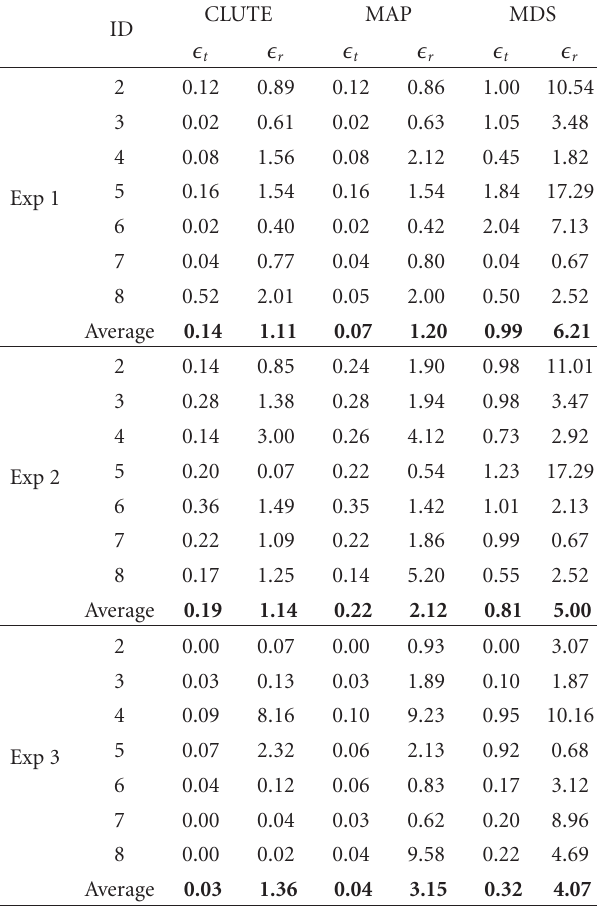
Table 6: Performance comparison between CLUTE , MAP , and MDS on the three datasets (8-camera